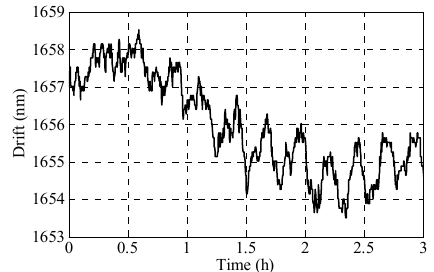
Figure 9. Stability test results of the probe.